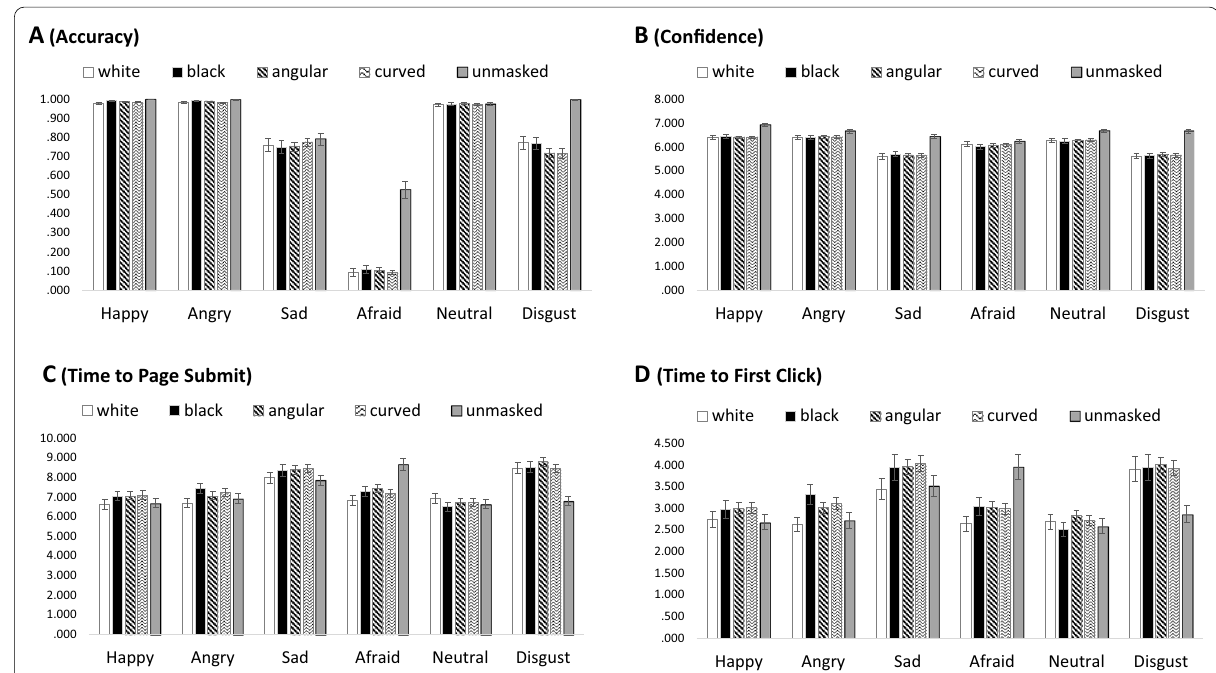
Fig. 2 Recognition accuracy, confidence, and response time for masks’ rating task. Note : Error bars represent standard errors of the